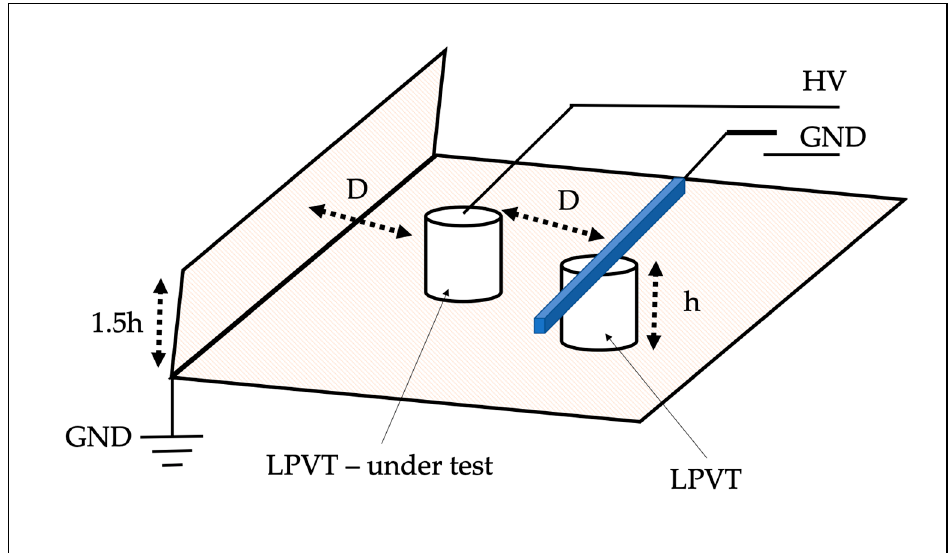
Figure 2. Setup used to test the low-power voltage transformers (LPVTs) when external electrical fields are acting on them.